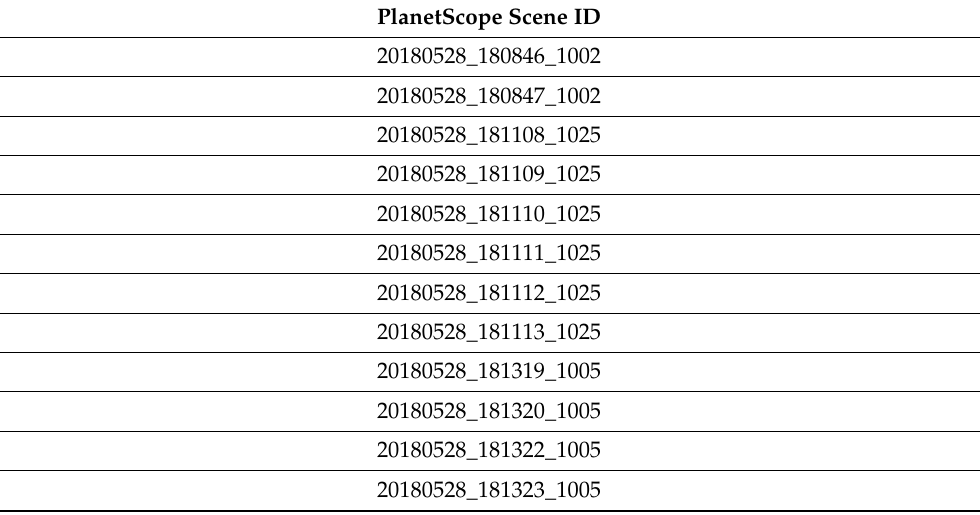
Table A7. Performance metrics (F-score) in forest classes using different forest canopy